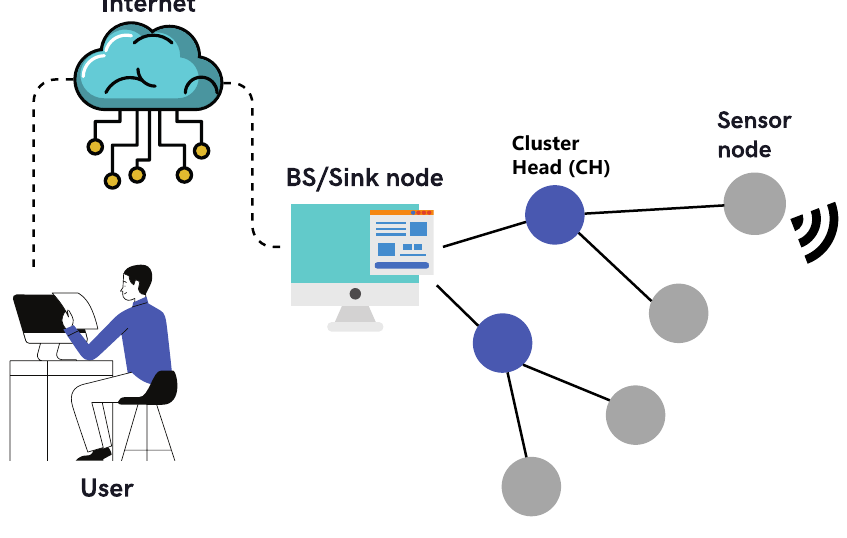
Figure 1. Typical WSN